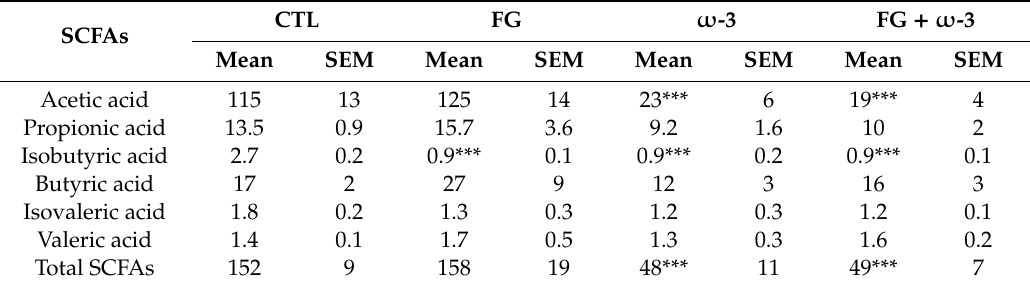
Butyric acid 17 Isovaleric acid Total SCFAs 152 158